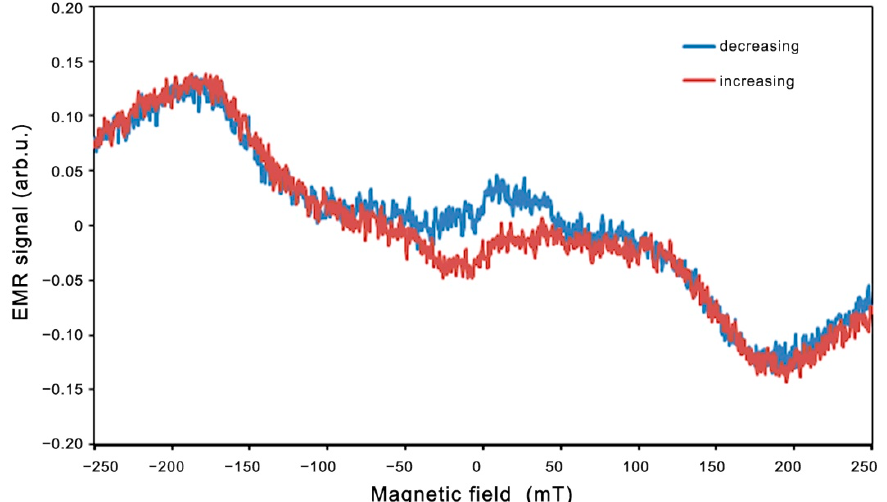
A similar hysteresis of the LFMA line was observed for Zn 0.8 Co 0.2 O/Ag on a silicon substrate, shown in Figure 10.